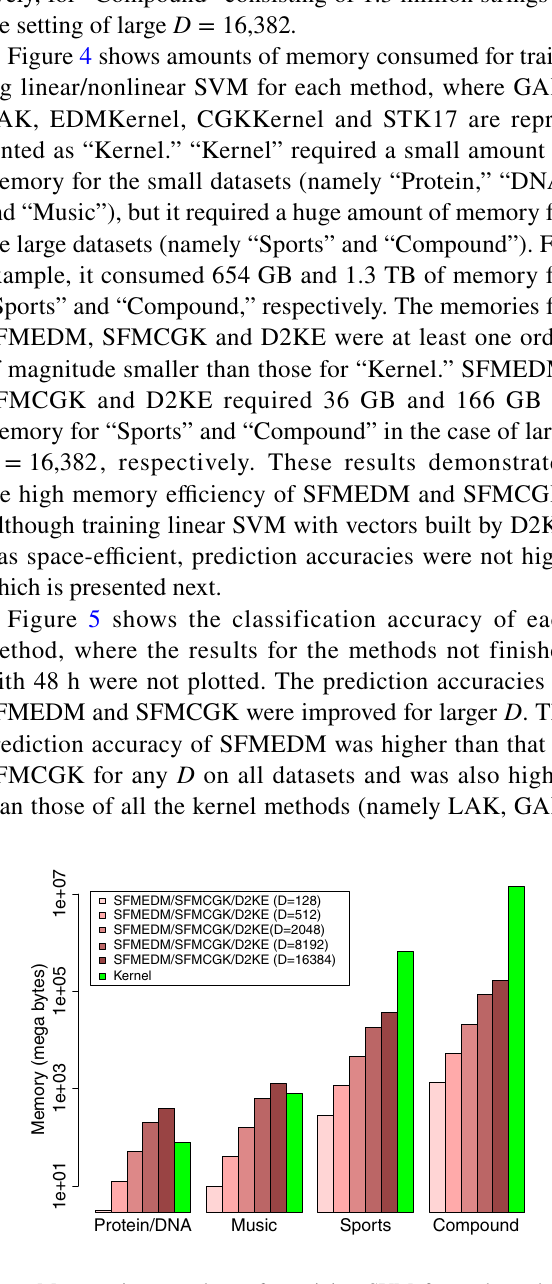
Fig. 4 Memory in mega bytes for training SVM for each